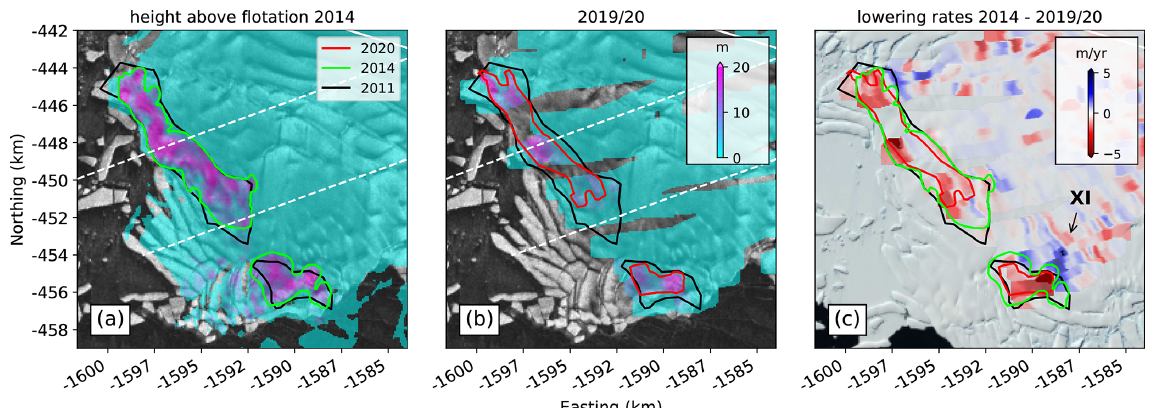
Figure 5. Close-up of the pinning point area and calculated height above flotation (a) from REMA and (b) ICESat-2 data. (c) Lagrangian rates of surface lowering. Red colors indicate thinning, while blue areas delineate thickening. The green and red lines show the reduced extent of the pinning point as estimated from height above flotation in 2014 and 2019/20, respectively. Map background is a Sentinel 1 SAR image from October 2019 and the Landsat Image Mosaic of Antarctica (Bindschadler et al., 2008). The Roman numeral in panel (c) refers to an area of interest discussed in the